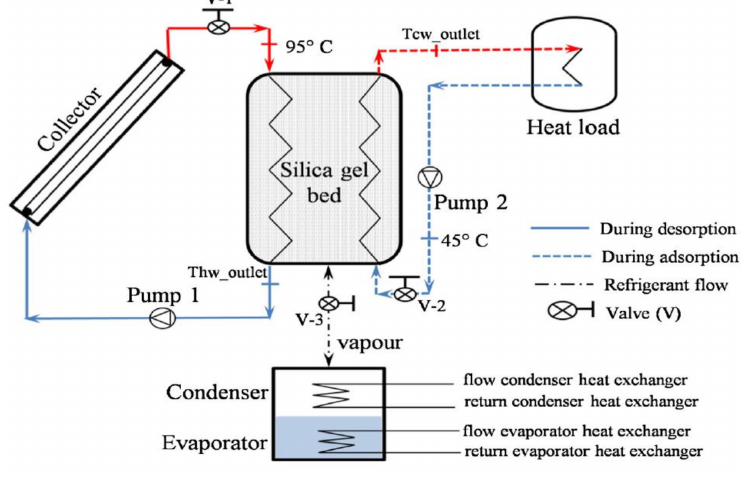
Figure 7. Solar-assisted adsorption system utilizing silica gel [74].